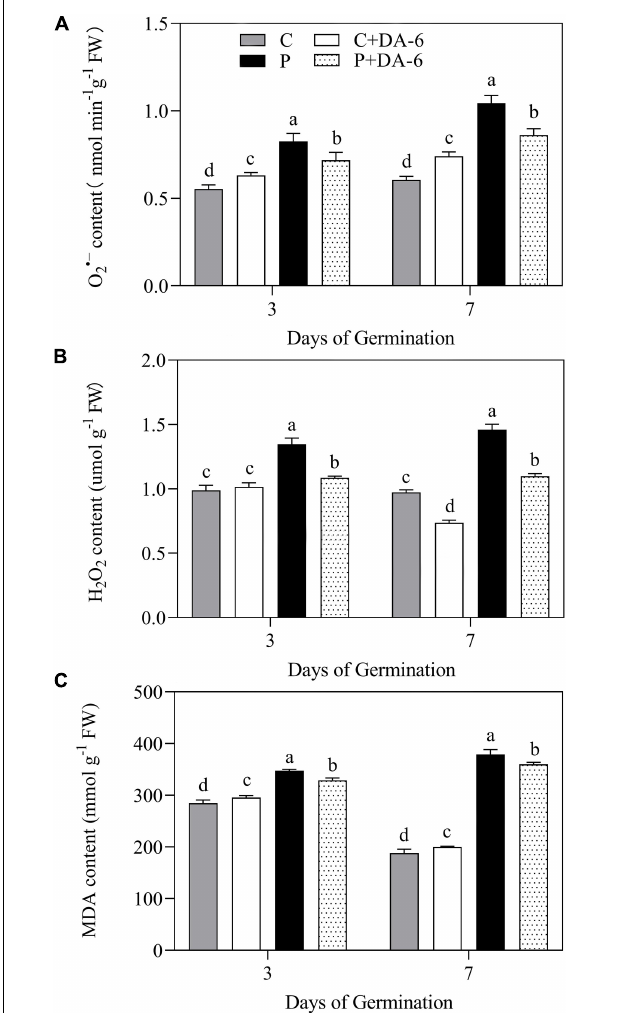
FIGURE 6 | Effect of seed priming with distilled water or DA-6 (2mM) on (A) O 2 - content, (B) H 2 O 2 content, and (C) MDA content after 3 and 7 days of germination in white clover under well-watered condition and drought stress. Different letters above different treatments represent significant differences at a specific time point under well-watered condition or drought stress ( p ≤ 0.05). Vertical bars show the ± SE of mean ( n =